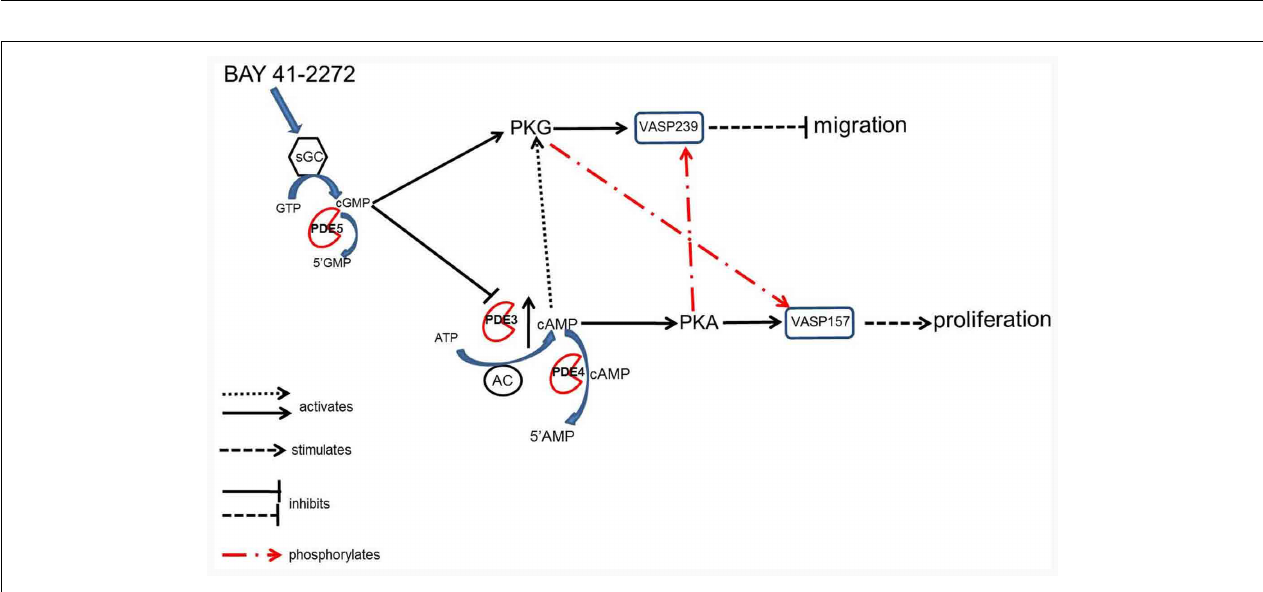
FIGURE 9 | (A) Effect of inhibitors of PDEs on 8Br-cAMP-inducedVASPSer 239 phosphorylation.VSMCs treated with 8Br-cAMP (10 μ M) in the absence or presence of cilostazol (CILO, 10 μ M), rolipram (ROL, 10 μ M), zaprinast (ZAP, 10 μ M), or vardenafil (VAR, 50nM), ( n = 3).Values are the means ± SE. *Different from vehicle control ( P < 0.05); † different from all other values